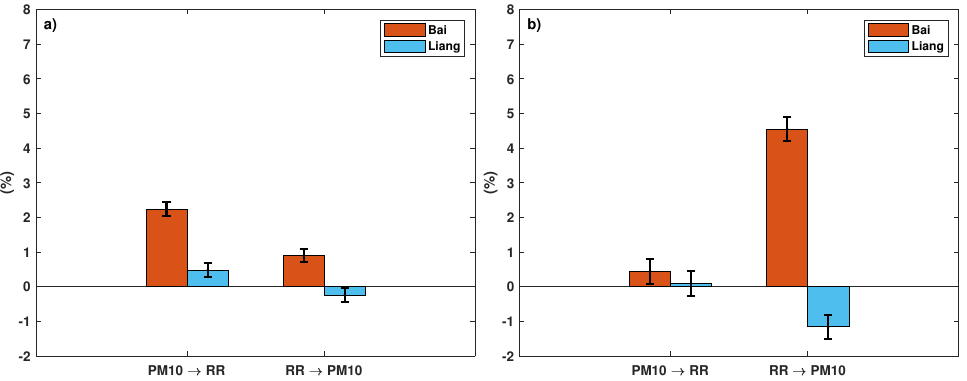
Figure 7. Relative information flow from PM 10 to RR and RR to PM 10 using Bai ( τ B , in orange) and Liang ( T L , in blue) methods for ( a ) dry (December to June) and ( b ) wet (July to November) seasons over 11 years. The standard error (95% significance level) is represented by the whiskers.